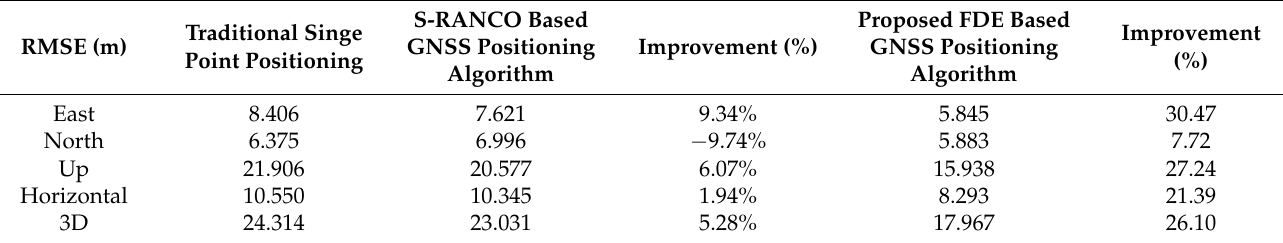
Table 11. Positioning accuracy results from the urban